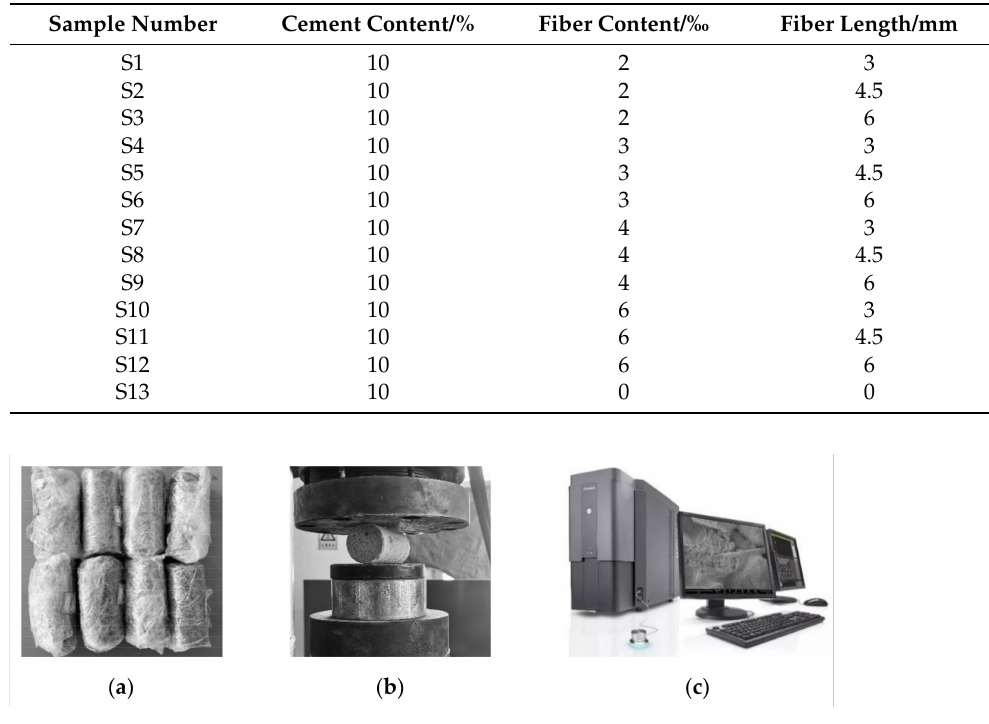
Figure 4. Sample preparation and test process. ( a ) Sample preparation and maintenance; ( b ) Splitting loading process; ( c ) Scanning electron microscopy